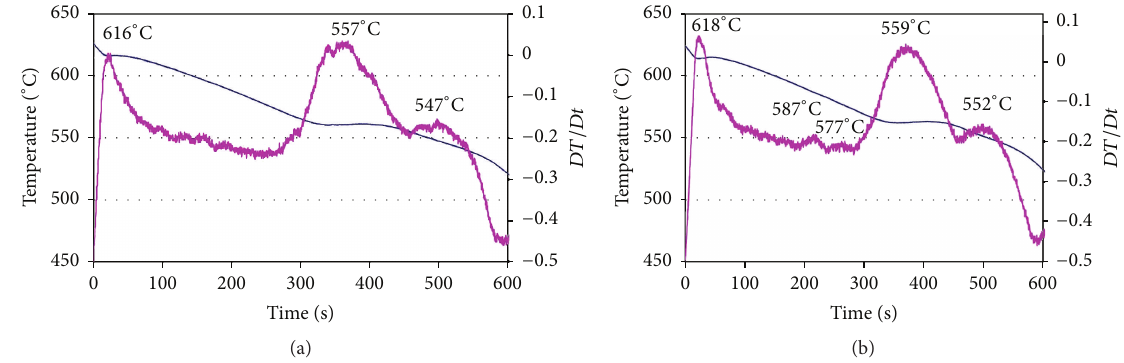
Figure 4: Solidification curve and the first derivative for (a) T0S alloy and (b) T9S